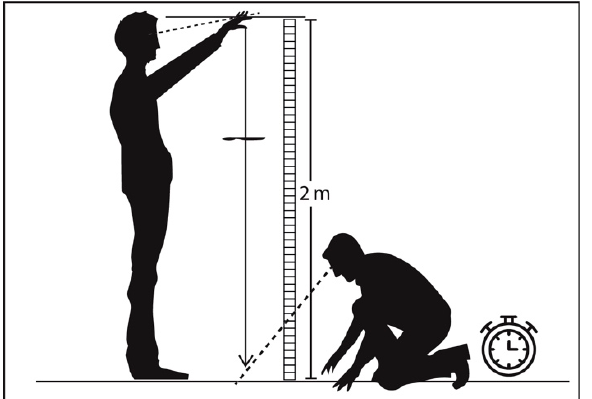
Figure 4. Simple indoor drop test in a controlled environment using harvested sycamore seeds.